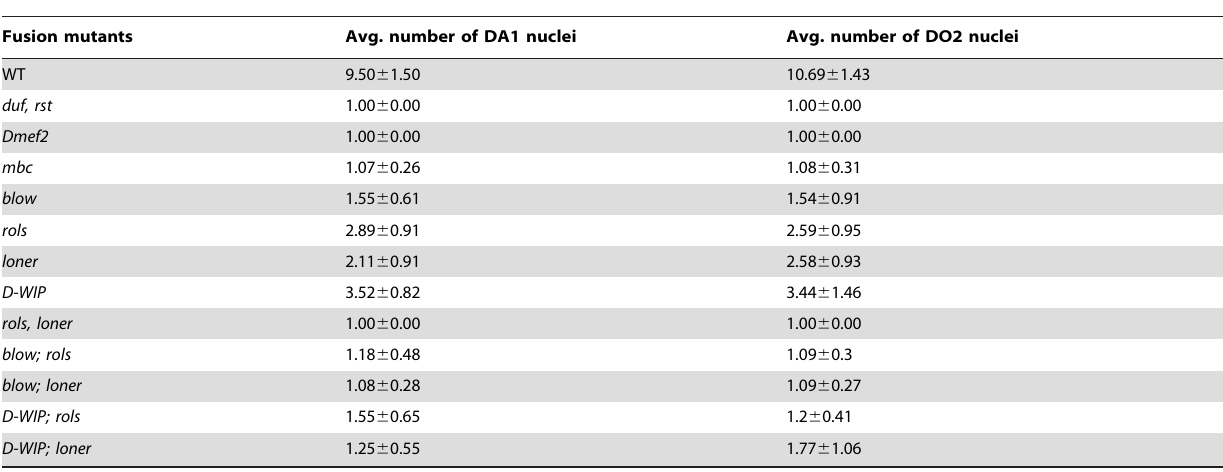
Table 2. Average number of DA1 nuclei in fusion mutants at late stage 15-early stage 16.